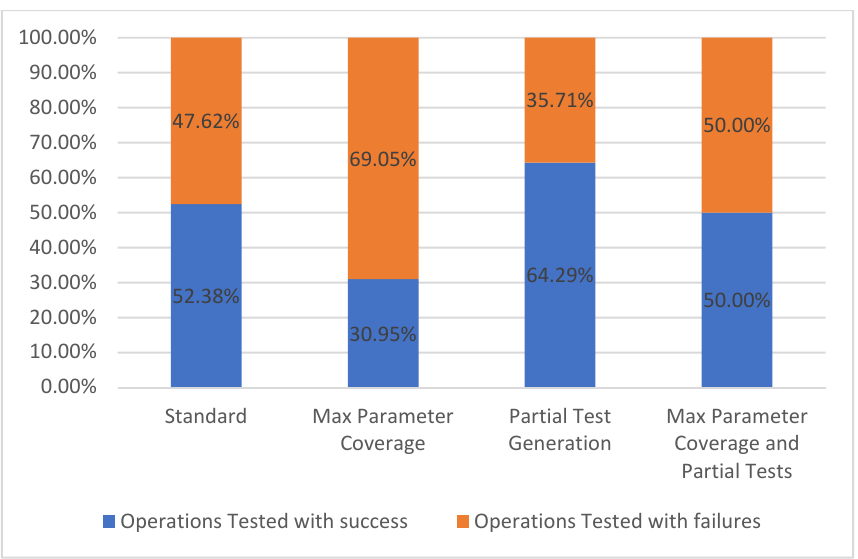
Figure 10. Operations tested.